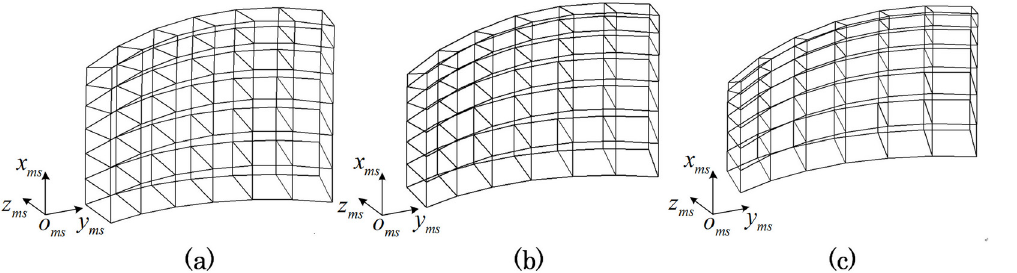
Fig 6. The spatial distribution of feature point. (a)Roll Angle: 0°~10° (b) Roll Angle: 10°~20° (c) Roll Angle: 20°~30° . In order to observe conveniently, the simulate curve has been divided into three parts by the roll angle. The other two angle of the curve are yaw angle from 0° to 60° and pitch angle from 0° to 60°. The angle between adjacent points is 10°.